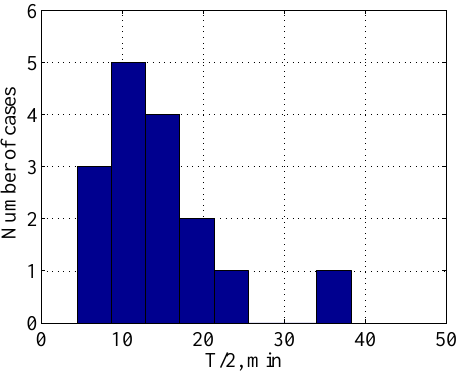
Figure 10. Distribution of flapping wave periods for our